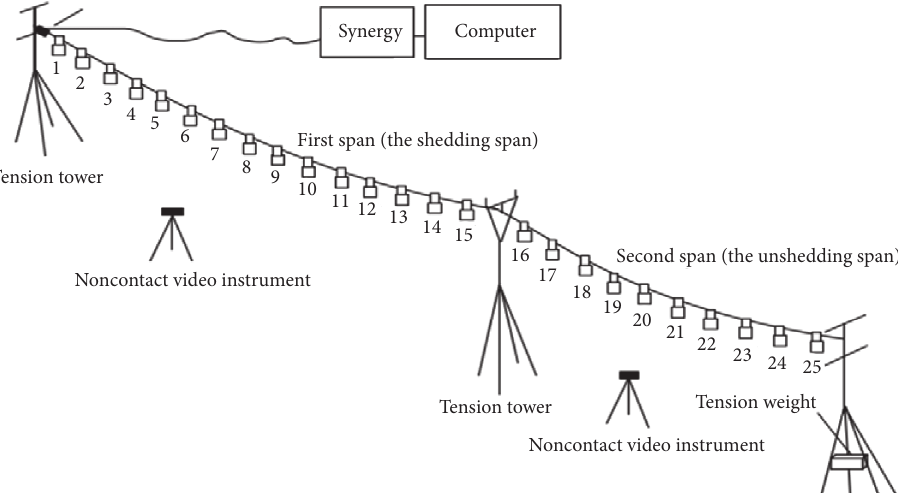
Figure 2: Schematic diagram of the test